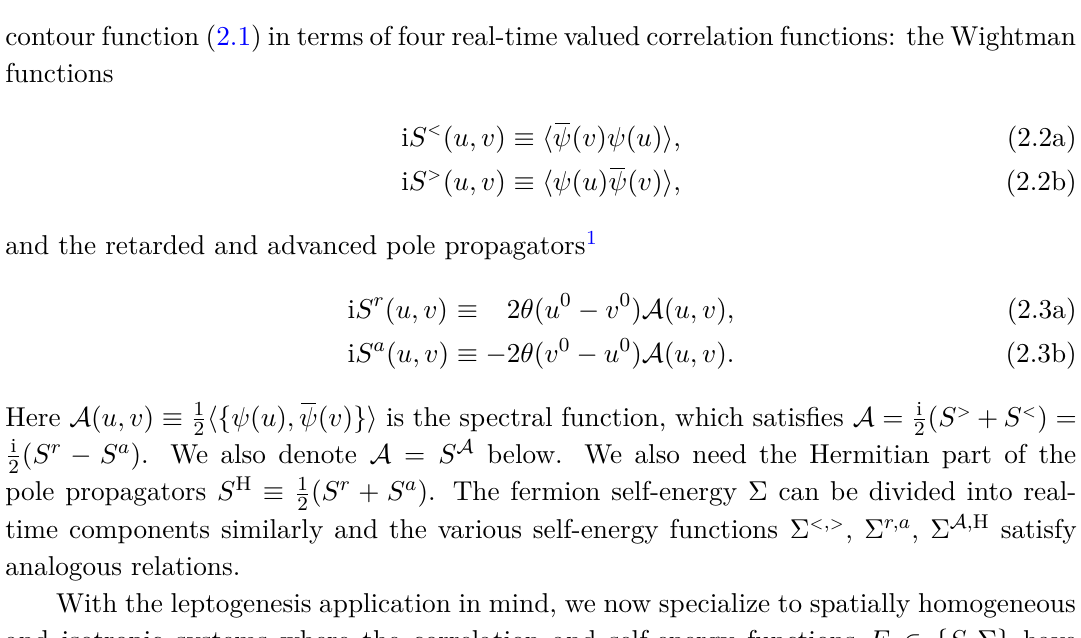
Figure 1. Shown is the Schwinger-Keldysh closed time path C . Arrows show the direction of increasing